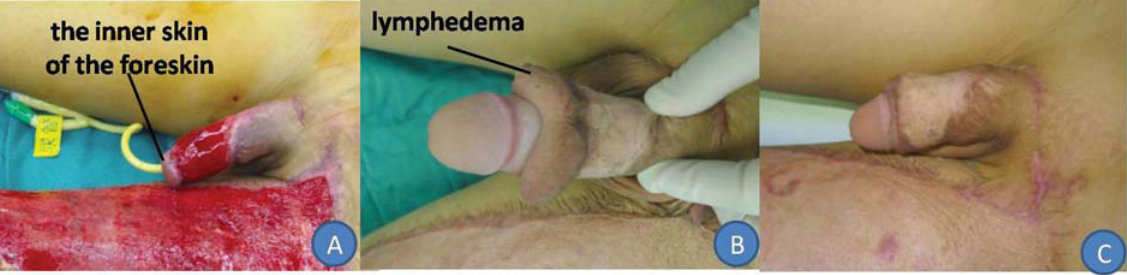
Fig. 4 A 12.5-year-old boy suffered a traf fi c accident-related penile injury and presented with tearing of most of the penile skin and part of the left thigh skin, and presented with retention of the inner side of the foreskin ( A ). The split-thickness skin graft survived completely; however, lymphedema of the distal penile skin had developed 1 year after surgery ( B ). After foreskin plastic surgery, the scar was observed to be fl at and hypopigmented ( C